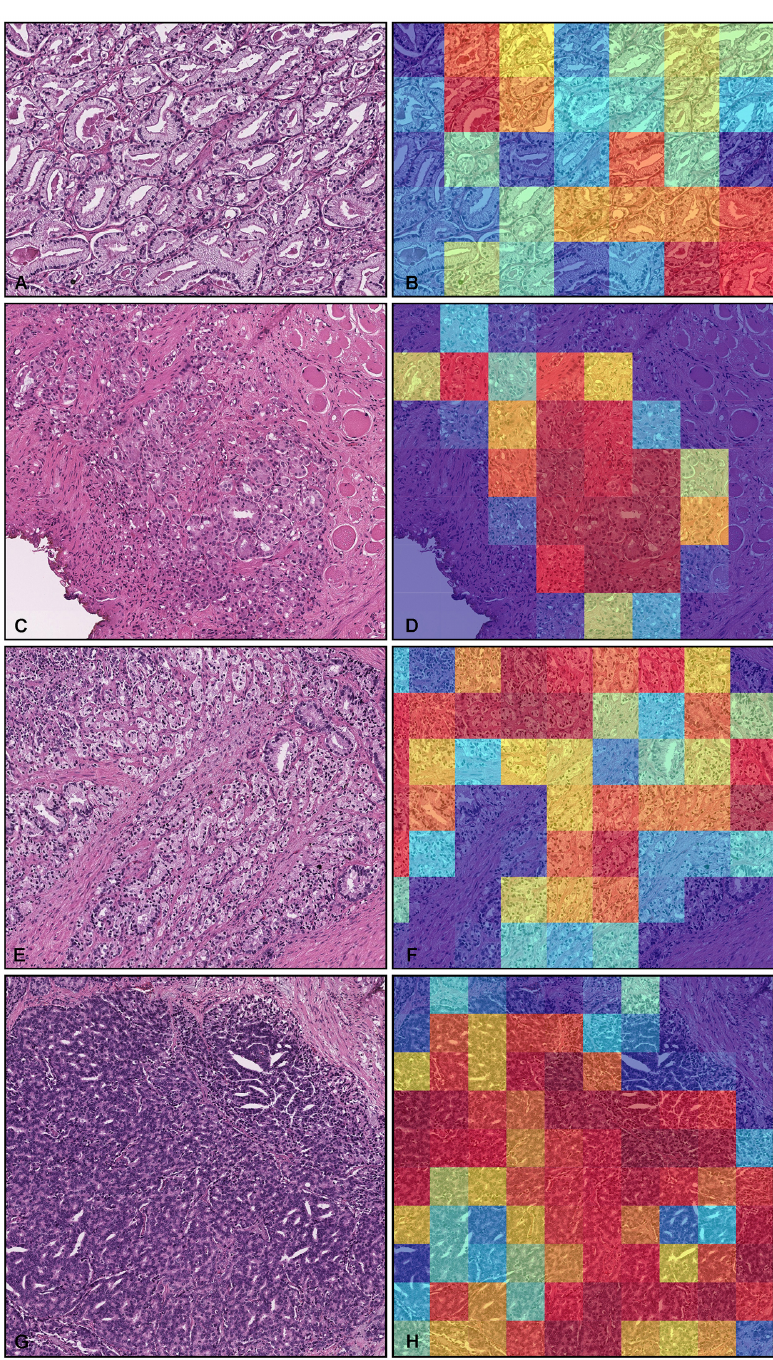
Figure 5. Representative histopathological examples of prostate adenocarcinoma true positive pre- diction outputs on whole-slide images (WSIs) from transurethral resection of the prostate (TUR-P) test sets using the model (TL-colon poorly ADC-2 ( × 20, 512)). Depiction of prostate adenocarci- noma histopathologies and corresponding heatmap images of adenocarcinoma prediction outputs: ( A , B ) medium-sized, discrete, and distinct neoplastic glands (Gleason pattern 3); ( C , D ) medium-sized discrete and distinct glands with ill-formed glands (Gleason score 3 + 4); ( E , F ) ill-formed glands (Gleason pattern 4); ( G , H ) cribriform pattern (Gleason pattern 4). The heatmap uses the jet color map where blue indicates low probability and red indicates high